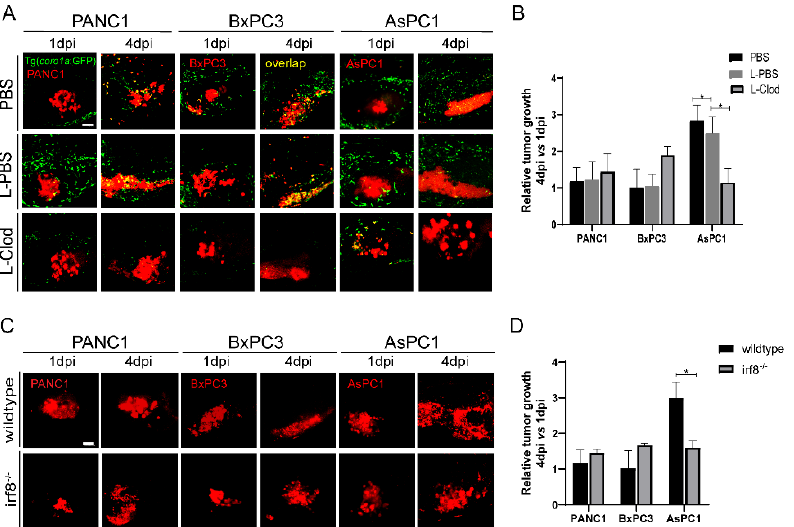
Figure 4. Zebrafish innate immune cells regulate PANC1, BxPC3, and AsPC1 tumor progression. ( A ) Representative confocal images of PANC1, BxPC3, and AsPC1 xenografts in embryos co-injected with PBS, L-PBS or liposome-clodronate (L-clodronate) at 1 dpi and 4 dpi. ( B ) Relative tumor cell growth for PANC1, BxPC3, and AsPC1 in PBS, L-PBS, or L-clodronate-treated groups. Results are from nine different individuals (* p < 0.05, t test). ( C ) Representative confocal images of PANC1, BxPC3, and AsPC1 xenografts in WT and irf8 -/- mutant embryos at 1 dpi and 4 dpi. ( D ) Relative tumor growth of PANC1, BxPC3, and AsPC1 in WT and irf8 -/- mutant embryos. Results are shown as means ± SEM from nine different individuals (* p < 0.05, t test). dpi, days post injection. Scale bar, 50 µm.